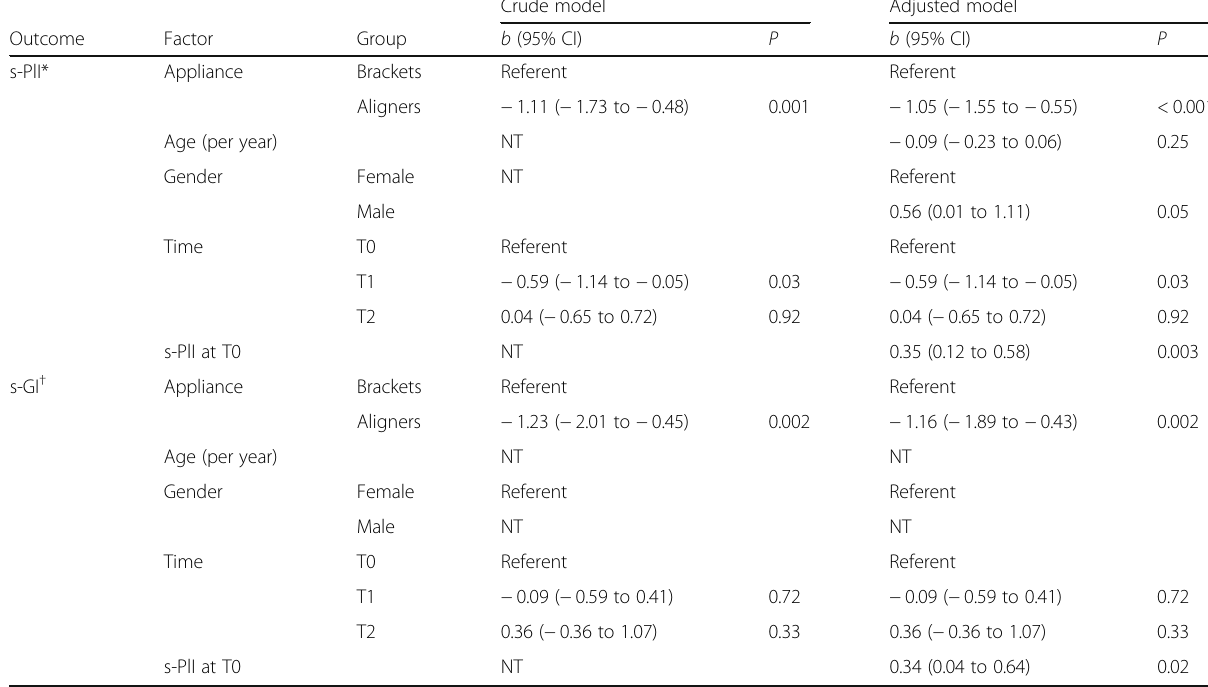
Table 3 Linear regressions with simplified plaque index or gingival index (both square root transformed) as dependent variable